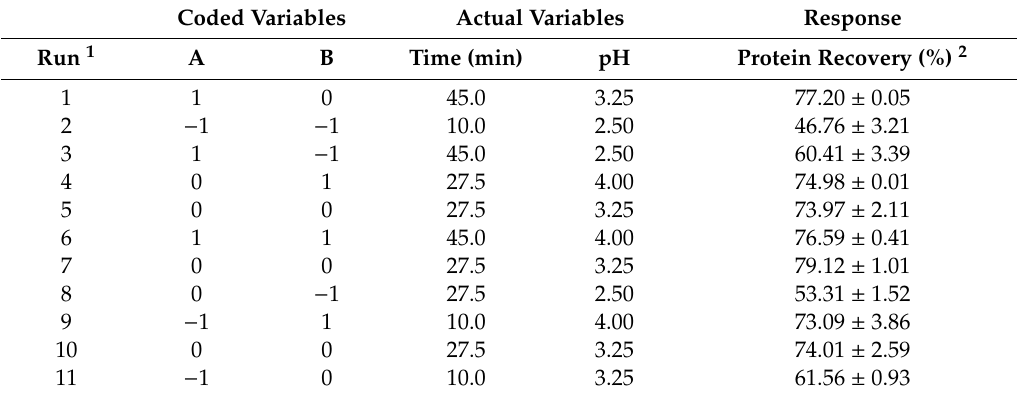
Table 2. Central composite response surface design for protein precipitation: